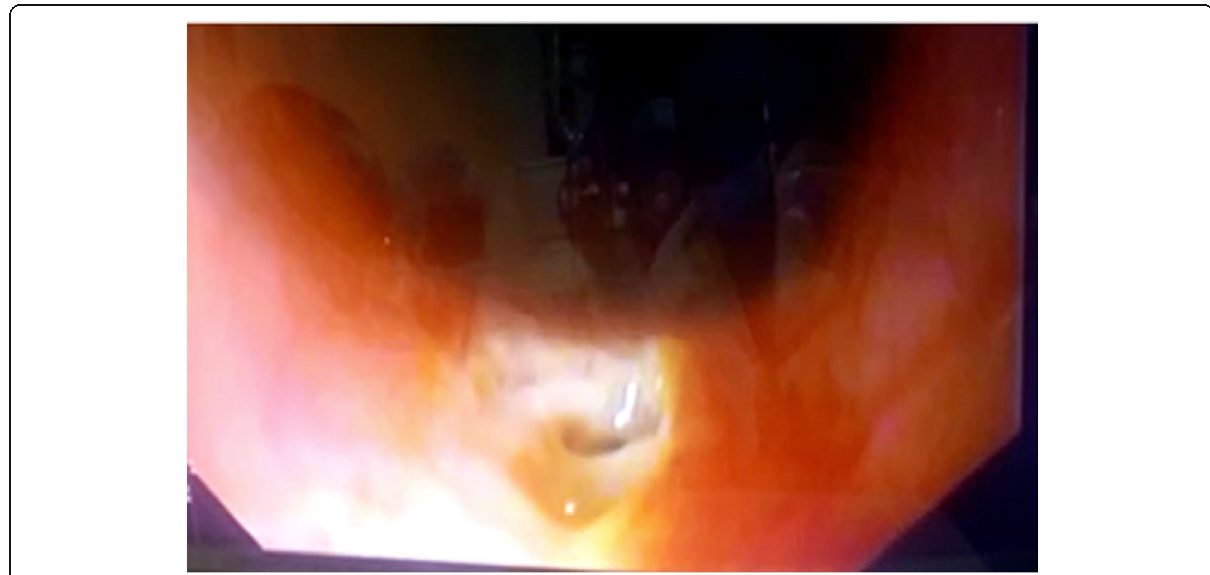
Fig. 3 Endoscopic picture of the thoracic esophageal